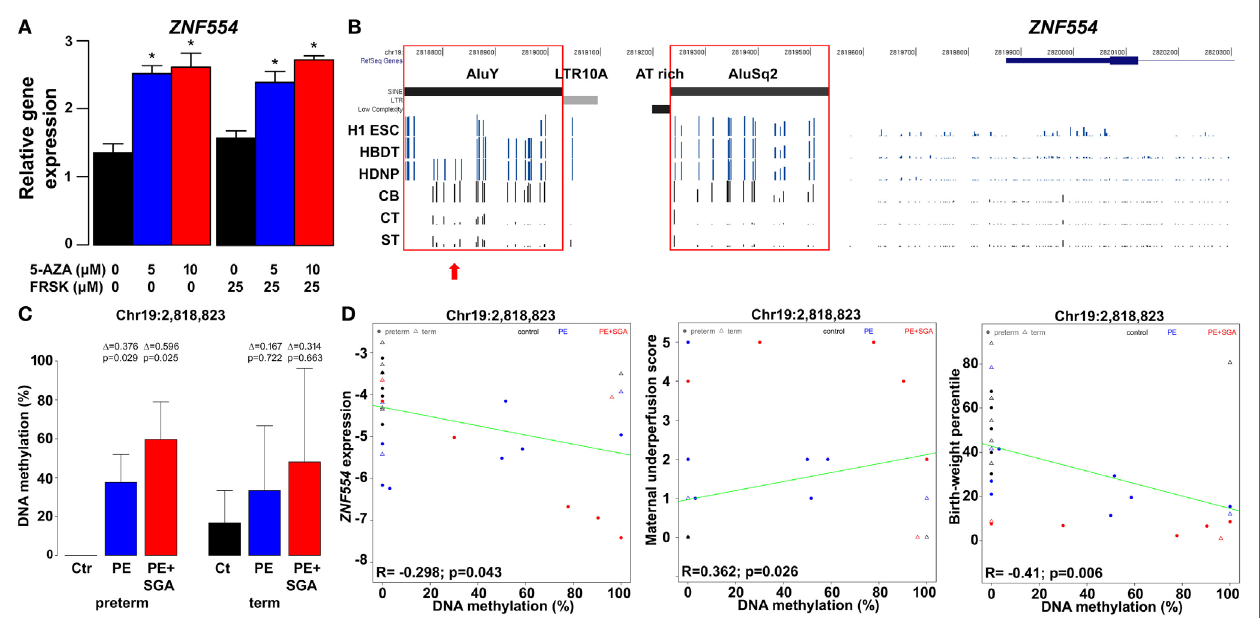
FigUre 11 | The effect of trophoblastic DNA methylation on ZNF554 expression and clinical parameters in preeclampsia. (a) Increased ZNF554 expression in BeWo cells upon treatment with 5-azacitidine (5-AZA) irrespective of forskolin (FRSK) co-treatment. (B) Upper three lanes : whole genome bisulfite sequencing data of ZNF554 5 ′ flanking region from the Human Reference Epigenome Mapping Project. H1 ESC, H1 embryonic stem cell; HBDT, H1 BMP4-derived trophoblast; and HDNP, H1-derived neuronal progenitor. Lower three lanes: bisulfite sequencing data from this study. Abbreviations: CB, cord blood cell; CT, cytotrophoblast; ST, syncytiotrophoblast. Red boxes: AluY and AluSq2 are heavily methylated in cord blood cells and hypomethylated in trophoblasts. Red arrow: CpG Chr19:2,818,823. (c) CpG Chr19:2,818,823 was differentially methylated in trophoblasts in preterm preeclampsia ± SGA. (D) Correlation was observed between Chr19:2,818,823 CpG methylation and ZNF554 expression, maternal vascular malperfusion score of the placenta, and birthweight